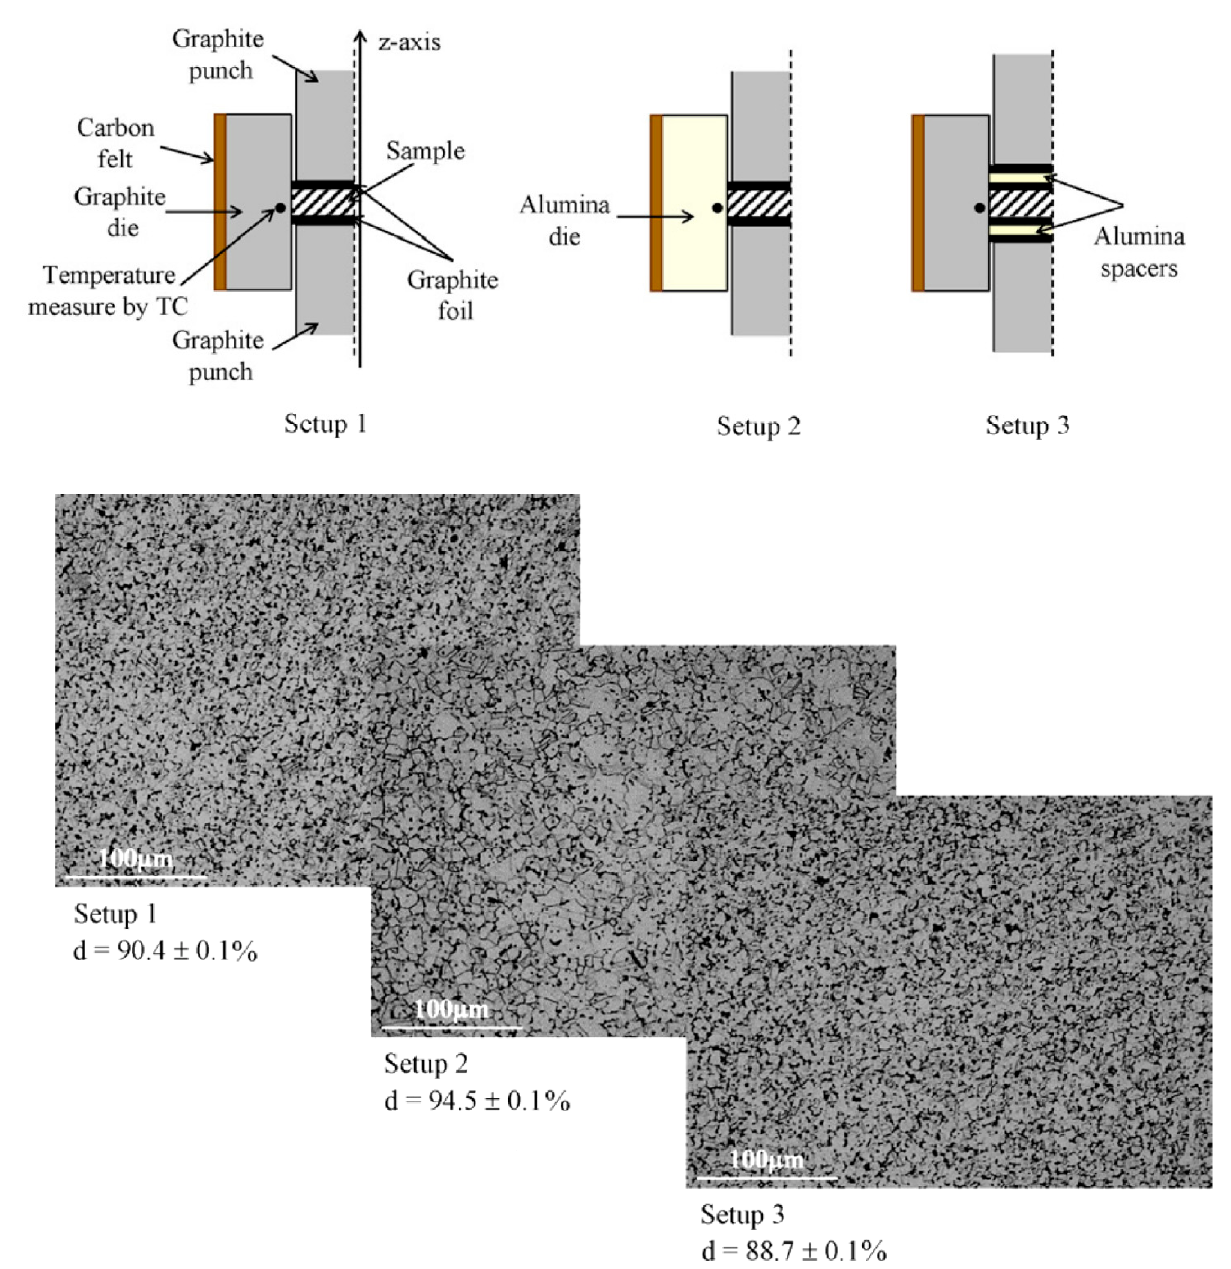
Figure 6. Relative density d of a Ni powder submitted to normal SPS conditions (setup 1), and to conditions where all of the SPS current flows through the sample (setup 2) and where the sample is electrically insulated (setup 3). Note in particular the difference in relative density d between samples processed using setup 2 ( d = 94.5%) and setup 3 ( d = 88.7%), showing an increase of sample relative density of about 5% due to the electric current [25]. Reproduced with permission from Journal of Alloys and Compounds , published by Elsevier, 2010.